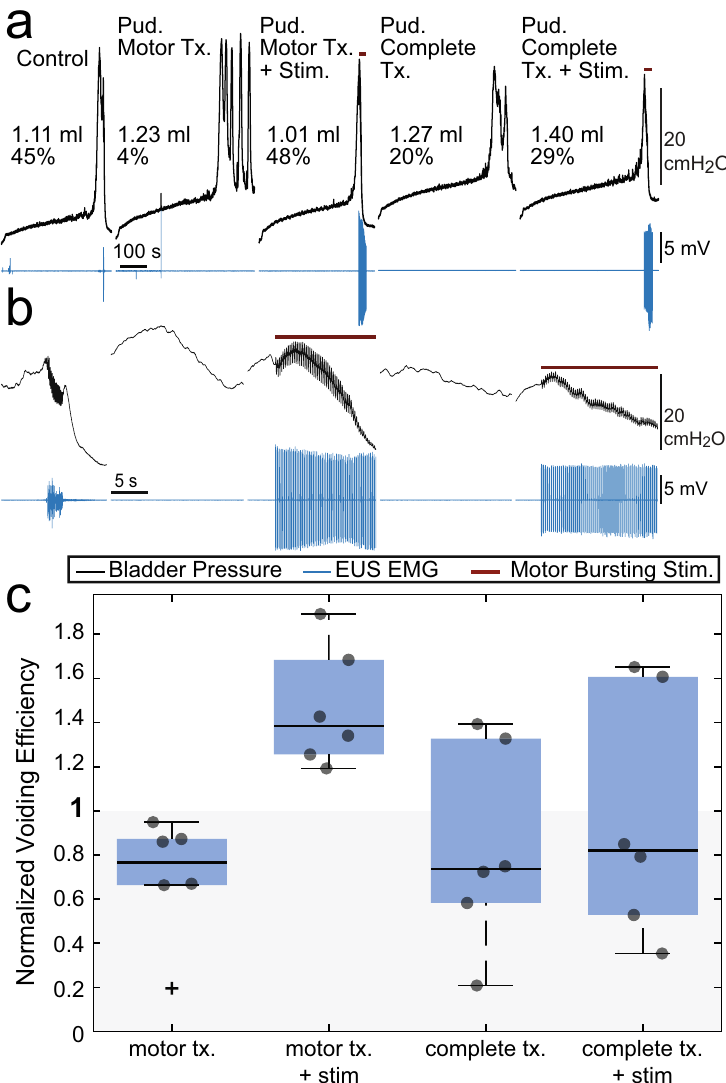
Figure 6. Motor-bursting stimulation in male rats after bilateral motor and sensory nerve transections. ( a ) Example cystometric traces from all five trial types with bladder pressure in black and EUS EMG in blue. Brown lines above the traces indicate the duration of motor bursting stimulation (3 pulses at 40 Hz at 5 Hz burst repetition frequency, efferent activation only due to transection). ( b ) Same trials as ( a ), but zoomed-in to show more clearly bladder pressure during voiding. ( c ) Average VE in each condition. Motor-bursting increased VE in all rats (P = 0.0082, n = 6, vs. controls; P = 0.013, n = 6, vs. motor transection, tx.). Following complete pudendal nerve transection motor-bursting failed to increase VE to the same level as when the sensory pudendal nerves were intact (P = 0.031, n = 6). Repeated measures one-way ANOVA P = 0.048. Follow-up testing conducted using the two-stage linear step-up procedure of Benjamini, Krieger, and